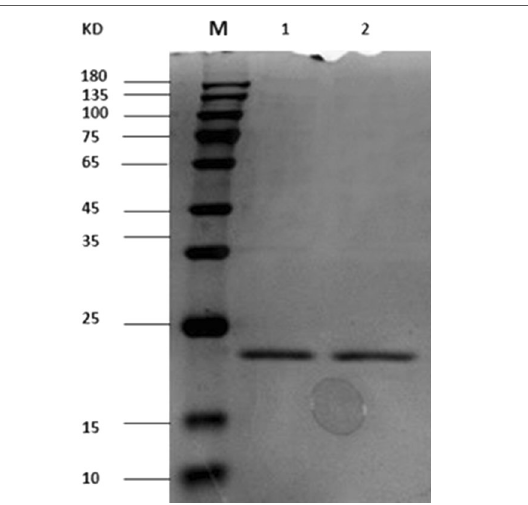
Fig. 7 Expression and purification of the recombinant sdAbs. The plasmids of sdAb 5 and sdAb 31 from phage ELISA were isolated, and the VHH gene was digested with Nco I and Not I and ligated to pET-25b ( ) –SBP. The SDS-PAGE results showed that the + recombinant sdAb 5 and sdAb 31 antibodies were expressed in a soluble form with an expected molecular weight of 20 kDa and could be successfully purified from Ni–NTA agarose